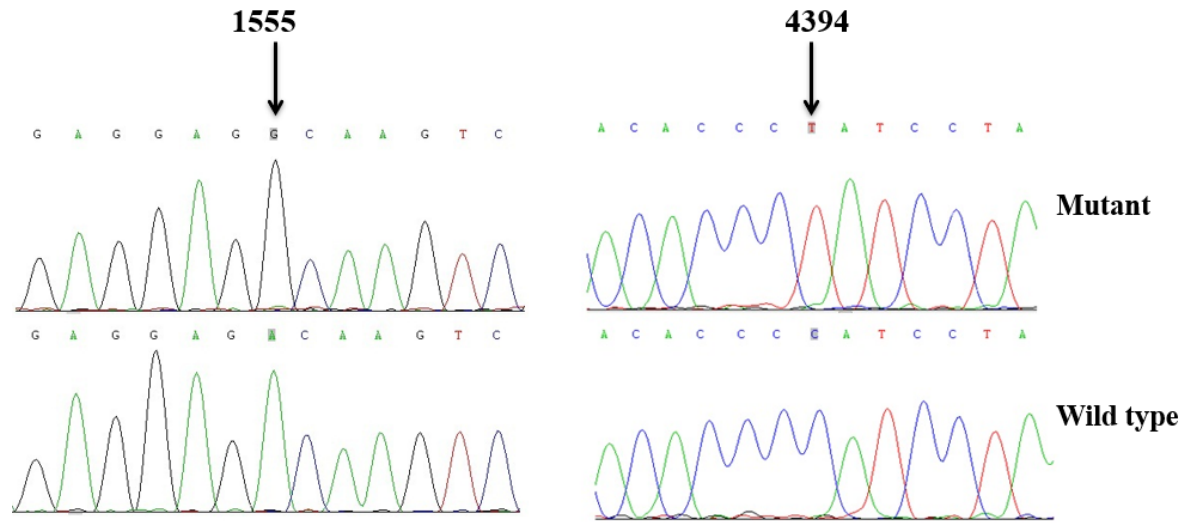
Figure 3. Identification of the m.1555A>G and m.4394C>T mutations via Sanger sequencing, partial sequence chromatograms of 12S rRNA and tRNA Gln gene from affected individual and a Chinese control. Arrows indicate the location of the base changes at positions 1555 and 4394.